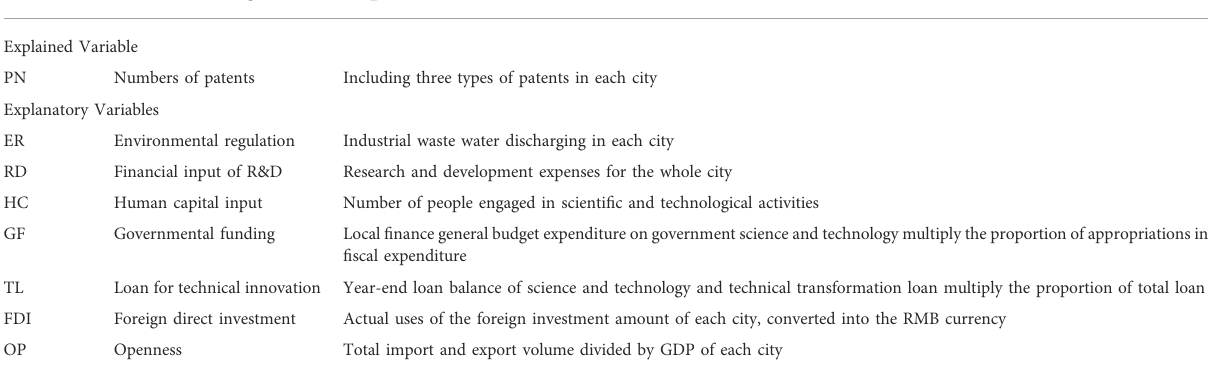
TABLE 1 Variables de fi